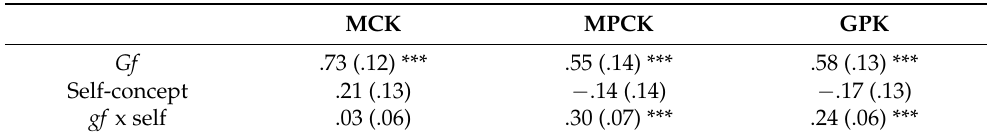
Table 6. Latent moderated structural equation model: standardized regression coefficients for the effects of the independent variables gf and academic self-concept, and their interaction on MCK, MPCK, and GPK (standard errors in